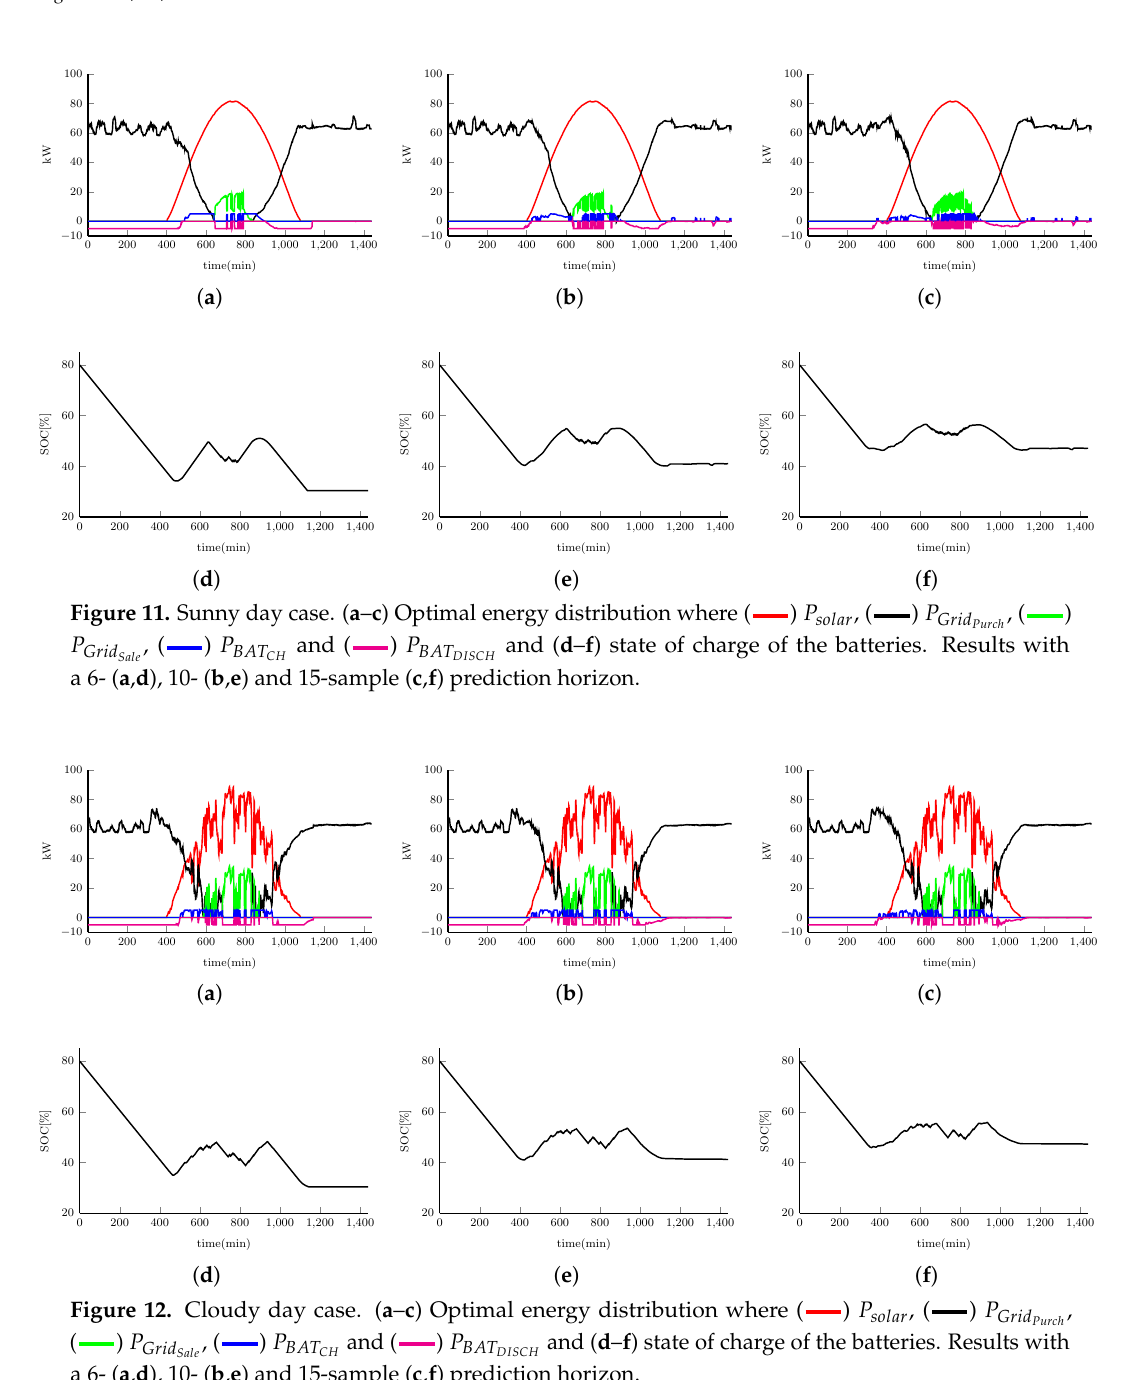
Figure 12. Cloudy day case. ( a – c ) Optimal energy distribution where ( ) P solar , ( ) P Grid ( ) P Grid , ( ) P BAT and ( ) P BAT and ( d – f ) state of charge of the batteries. Results with CH DISCH Sale a 6- ( a , d ), 10- ( b , e ) and 15-sample ( c , f ) prediction